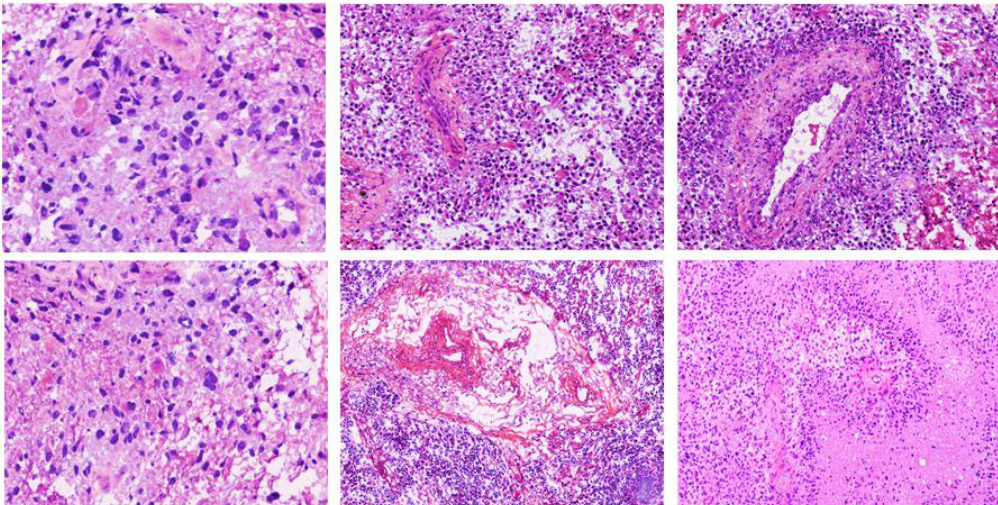
Figure 5. Images showing nuclear pseudopalisading, which is defined as the aggregation of tumor cells around the periphery of the necrotic areas, increased mitotic activity, and vascular proliferation. Pseudopalisading necrosis and vascular proliferation are the two important hallmarks of glioblastoma. The images were acquired using 20 × magnification